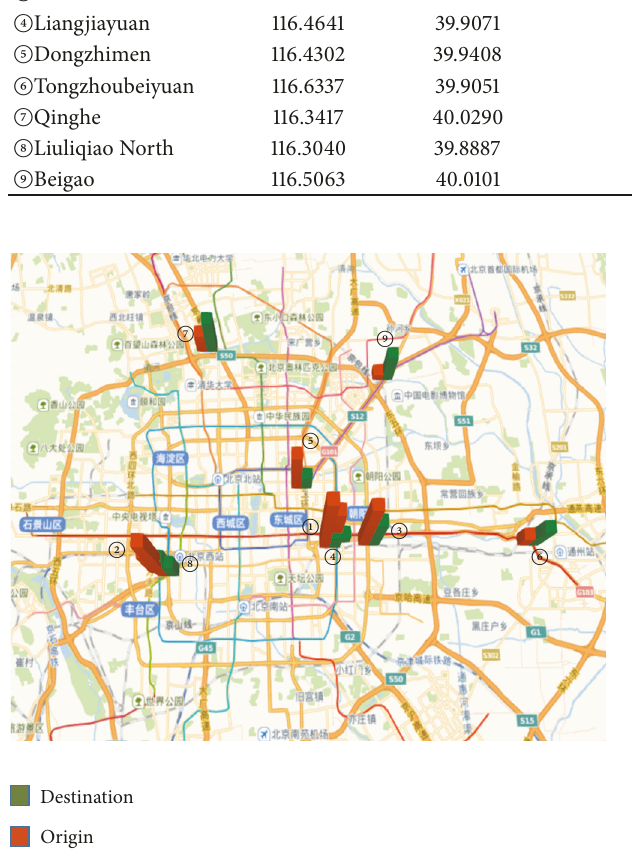
Figure 13: The relationship between four type passenger number and passenger travel